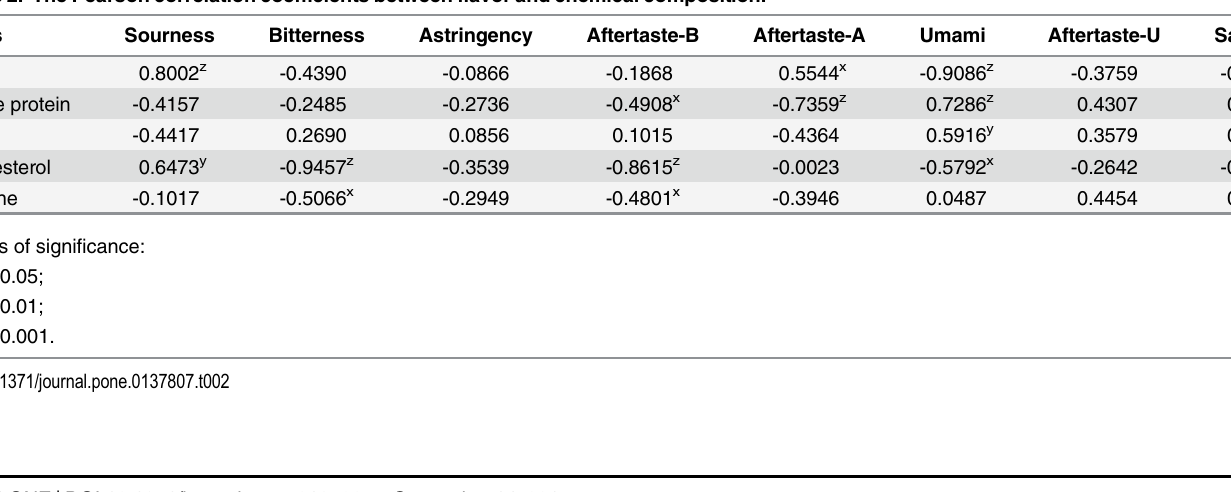
taste-B (r = − 0.4801, P < 0.05) showed negative correlation with taurine. Zhang et al (2004) found that supplements of a daily dose of 6 grams (2 grams three times a day) taurine powder (Taisho, Tokyo, Japan) for 7 days may attenuate exercise-induced DNA damage and enhance the capacity of exercise due to its cellular protective properties [25]. Therefore, Angus had lower bitterness level and was possibly a good choice for human health as it has the highest lev- els of taurine content according to the present study. Table 3 showed the regression formula between chemical composition and flavor. Accord- ing to Table 3, chemical composition could be predicted by its high correlation flavor traits. Therefore, the results indicated that flavor had a good prediction to chemical composition.